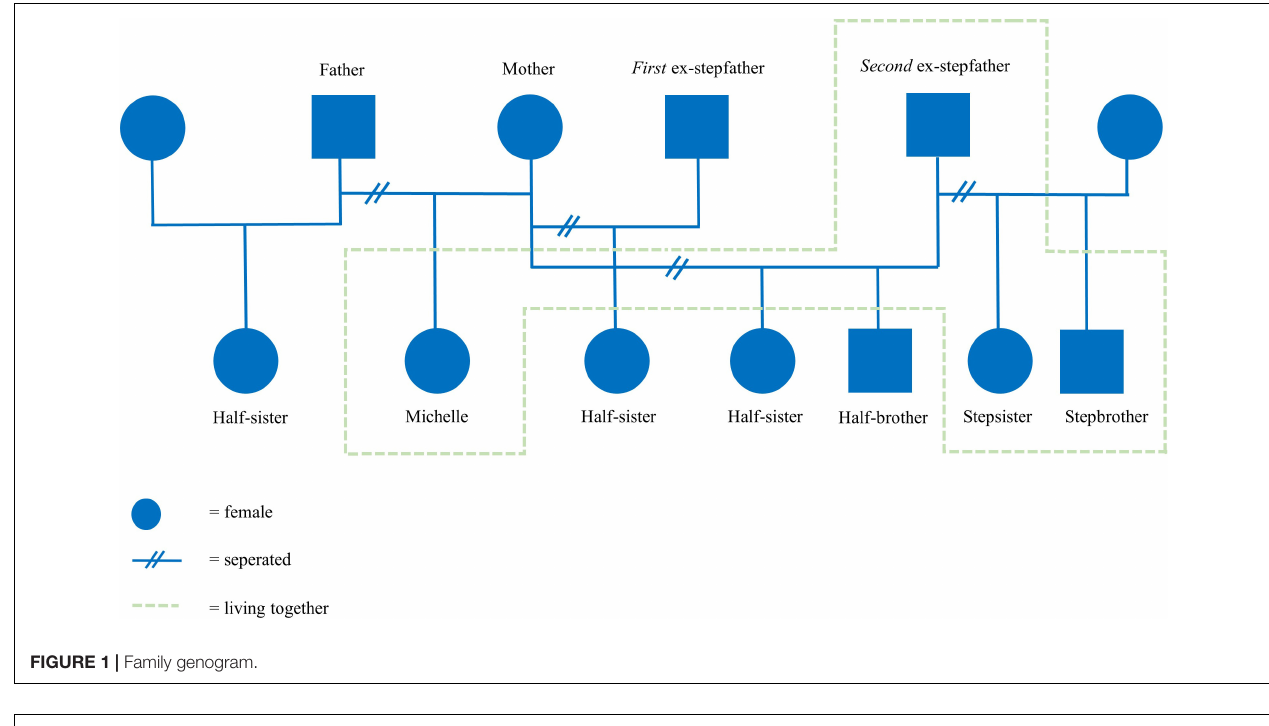
FIGURE 1 | Family genogram.